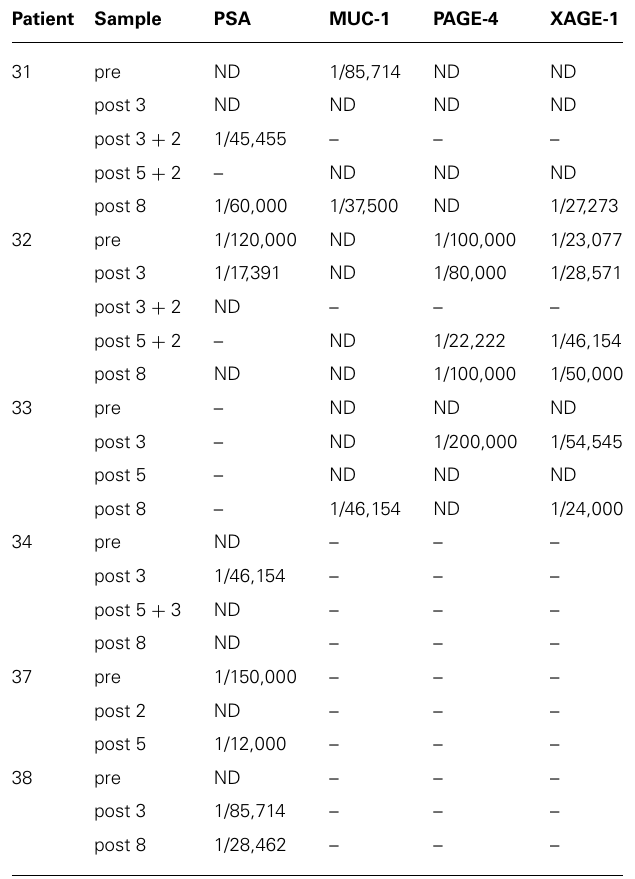
PAGE-4 and XAGE-1 denote members of the PAGE/GAGE family of prostate can- cerTAAs. ND, none detected ( < 1/200,000). Samples obtained after indicated vaccine cycle (i.e., post 3 + 2 = 2 months after cycle